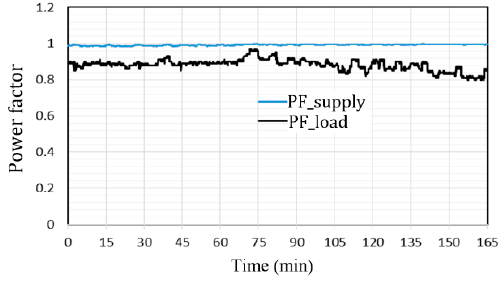
Figure 22. Evolution of the total power factor during recordings.